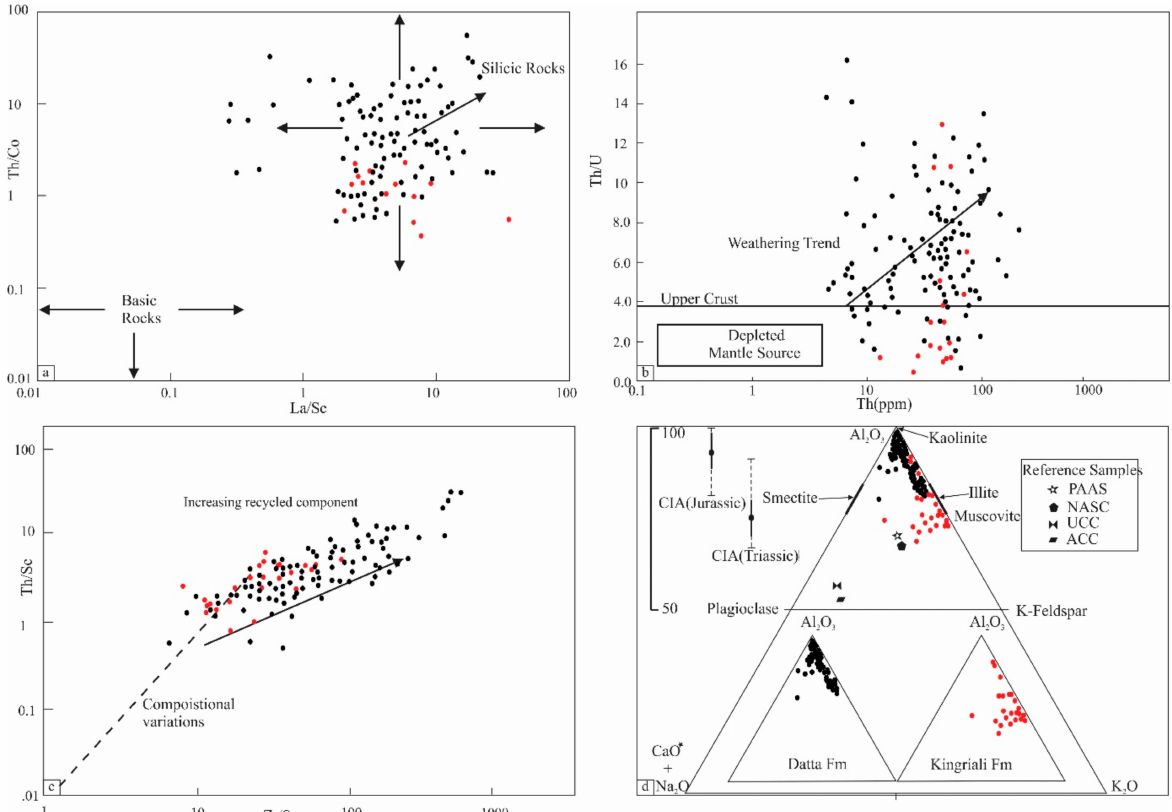
Figure 12. ( a ) Th/Co versus La/Sc plot [72] indicating sediment derivation from a silicic source; ( b ) Th/U versus Th(ppm) plot [69] favouring chemical weathering of the sediments; ( c ) Th/Sc versus Zr/Sc plot [71] supporting the recycled origin of the sediments; and ( d ) A–CN–K plot for the studied samples, where positions of reference minerals (muscovite, illite, smectite, and kaolinite) are indicated on the plot [92]. The Triassic and Jurassic samples are separated in the lower part of the plot and the CIA range (dotted and dashed lines) and average (black dots) are plotted to left for both the Triassic and Jurassic samples. PAAS = Post Archaean Australian Shale; NASC = North American Shale Composite; UCC = Upper Continental Crust; ACC = Average Continental Crust (ACC)